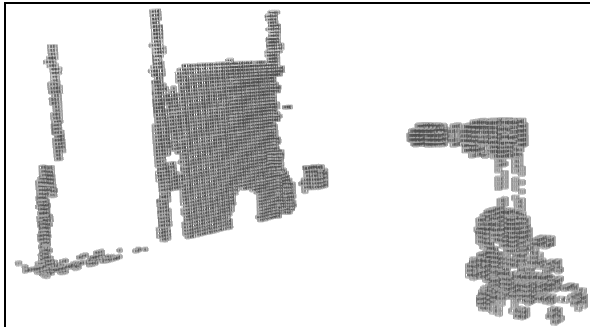
Figure 6: Illustration of both centre points and cubes in Octree with 10mm sidelengths for both the robot and the